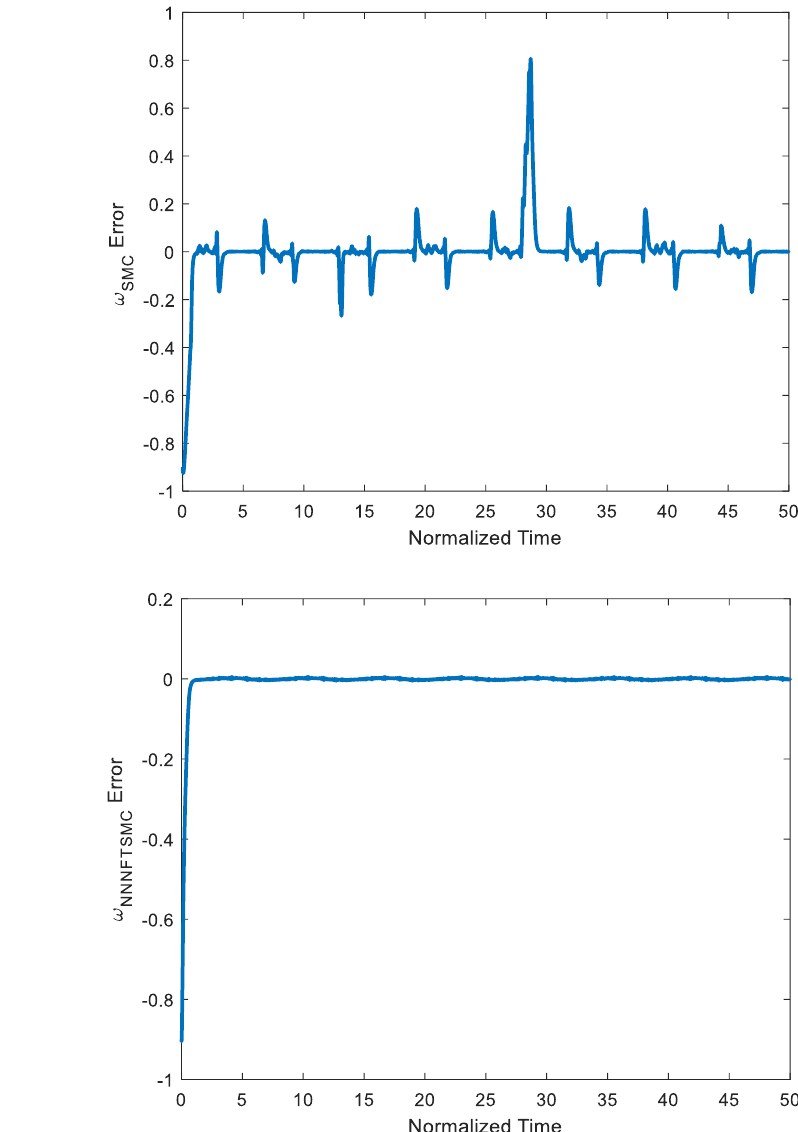
Figure 13. Periodic response of HTGS under random noise ( a ) SMC and ( b ) proposed controller.